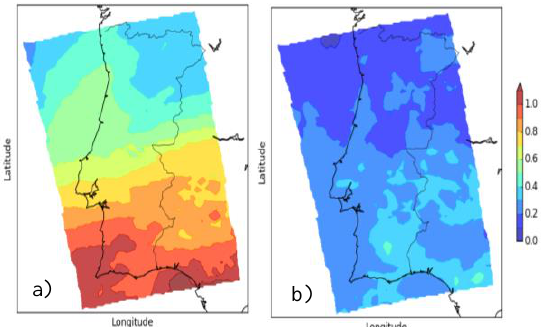
Figure 11. Statistical analysis between CAMx results and SEVIRI observations for 10th -17th of May 2011. a) Mean bias and b) Root mean square error. Spatial analysis of AOD over three regions of the study domain is given in Figure 12.